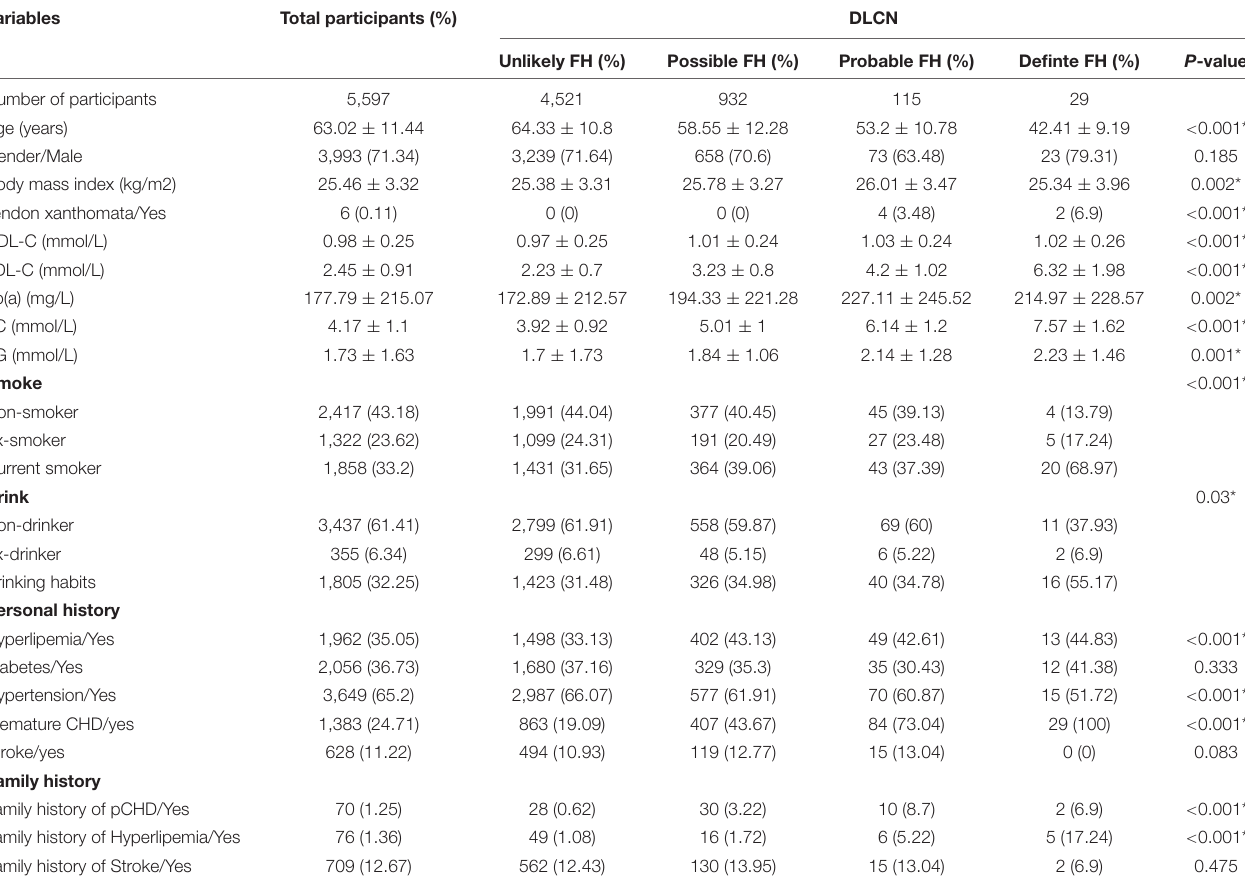
TABLE 1 | Clinical characteristics for familial hypercholesterolemia (FH) patients identified by DLCN.